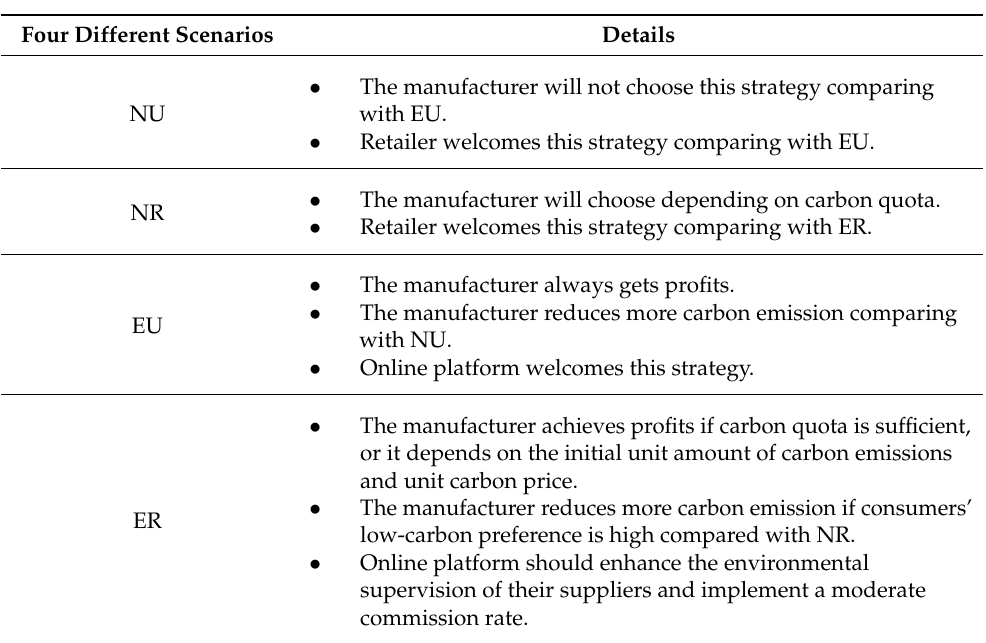
Table 3. Differences between the four scenarios in terms of chain